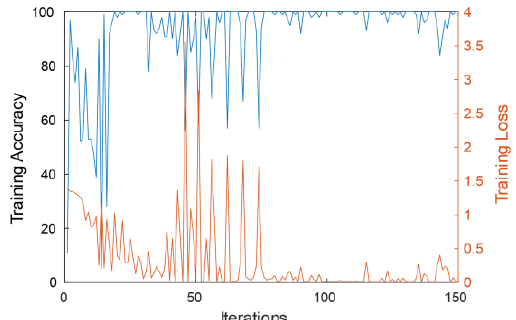
Figure 15. Loss and accuracy of the trained network for 4 classes.